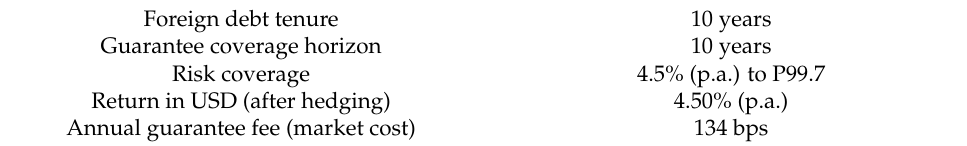
Table 4. Cost of the FX tail risk guarantee [13].